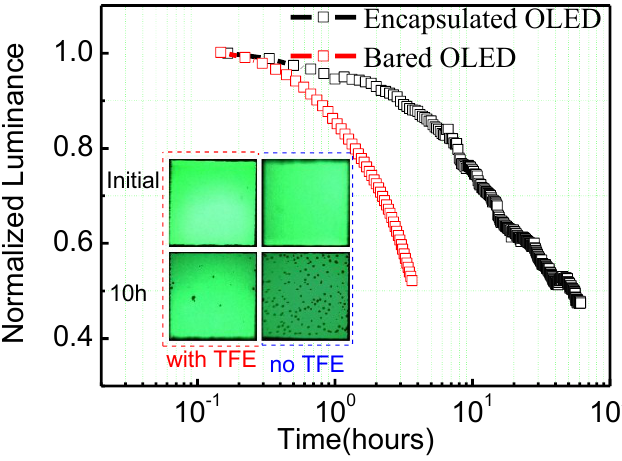
Figure 5. Luminance of OLED encapsulated with and without Al 2 O 3 thin films as a function of time measured under conditions of 25 °C and 60% RH, the inset shows the photos of the test OLEDs after 10 h.